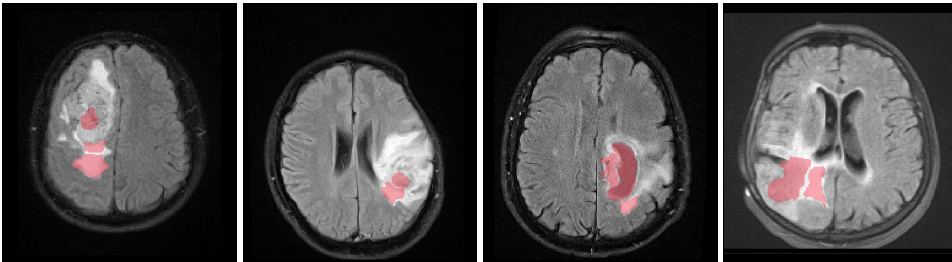
Figure 2. Four example slices from volumes of the in-house dataset that contain sparse and positive annotations. Most other slices of the volumes are annotation-free; at most one or two contain smaller additional annotations. The non-affected tissue is not